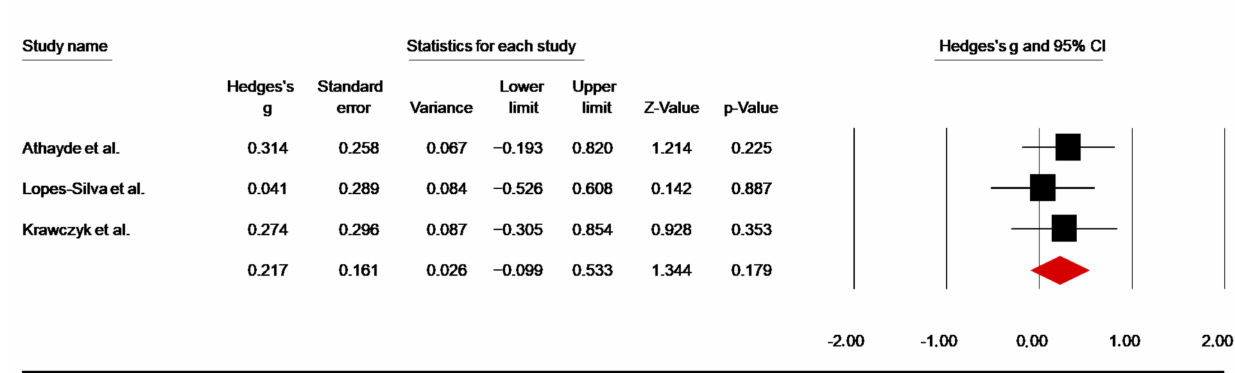
Figure 6. Forest plot of the effect of caffeine intake on judogi strength endurance test [46,53,59].